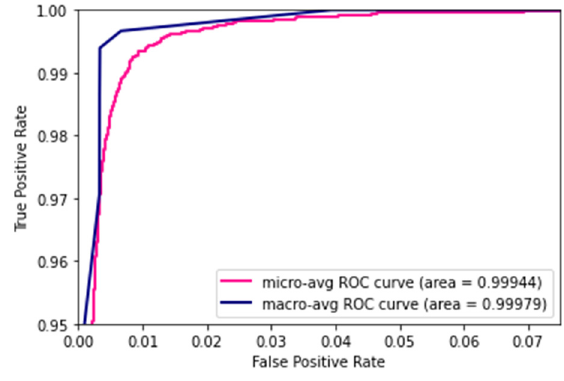
Figure 8. ROC plot. Figure 8. ROC plot.